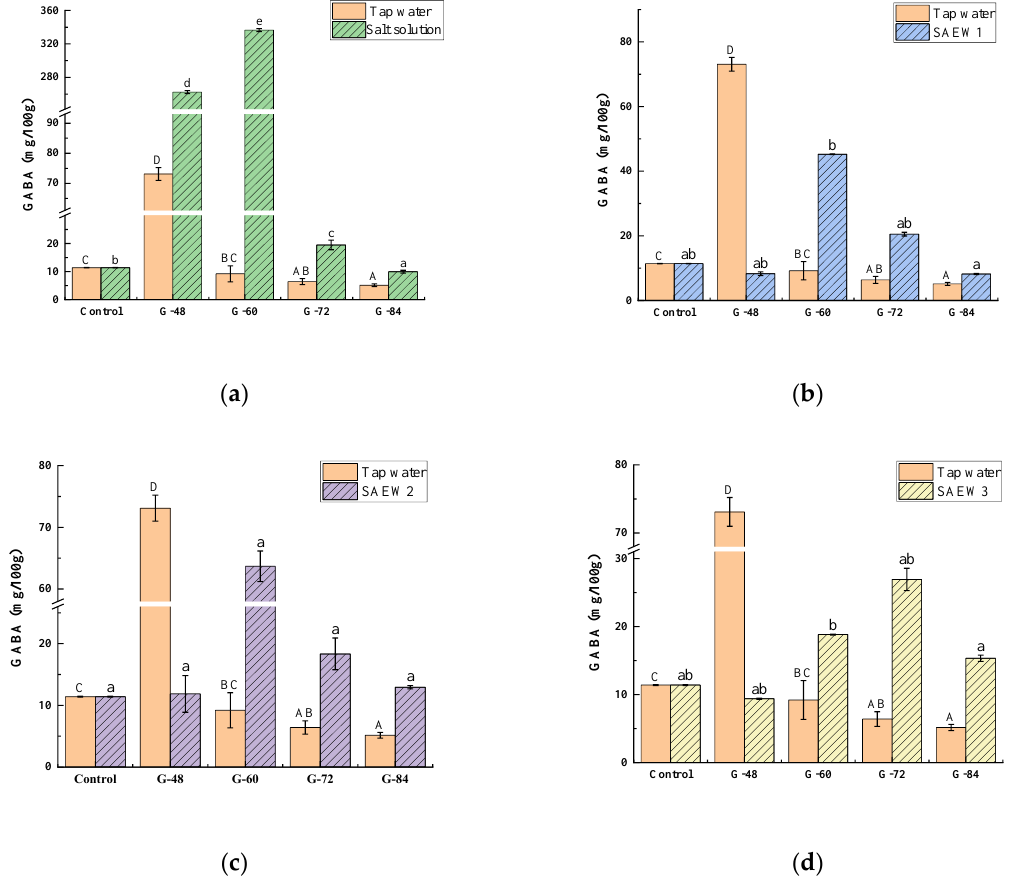
Figure 2. Effects of different germination conditions on the contents of GABA in germinated millet flour: ( a ) salt solution; ( b ) SAEW1; ( c ) SAEW2; ( d ) SAEW3. SAEW, slightly acidic electrolyzed water; SAEW1, 2, and 3 represent SAEW with ACC concentrations of 10.92, 20.25, and 30.35 mg/L, respectively; control, ungerminated millet flour; G-48, 60, 73, and 84 indicate germination for 48, 60, 73, and 84 h, respectively. Different capital letters indicate significant differences for tap water treatment and lowercase letters indicate significant differences for other sample solution treatments ( p < 0.05). Each value is expressed as the mean ± standard deviation of three